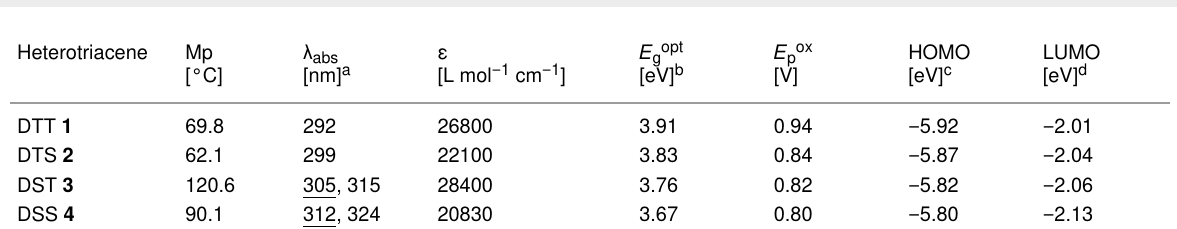
Table 4: Thermal, optical, and electrochemical properties of heterotriacenes 1 – 4